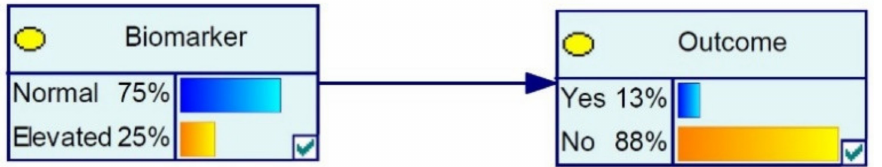
Figure 1. BBN with two nodes in an unobserved state, with Outcome being conditionally dependent on Biomarker state. Using GeNIe software Version 2.3 Graphical User Interface (GUI), the BBN is built up relationship by relationship and can immediately produce predictions based on observed or unobserved states using built-in